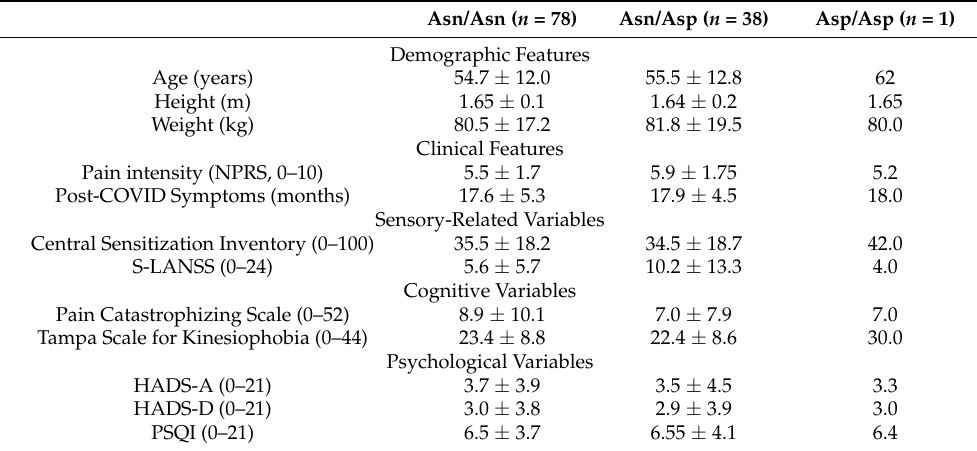
NPRS: numerical pain rate scale; HADS: Hospital Anxiety and Depression Scale (A: anxiety; D: depression); S-LANSS: self-reported version of the Leeds Assessment of Neuropathic Symptoms and Signs; PSQI: Pittsburgh Sleep Quality